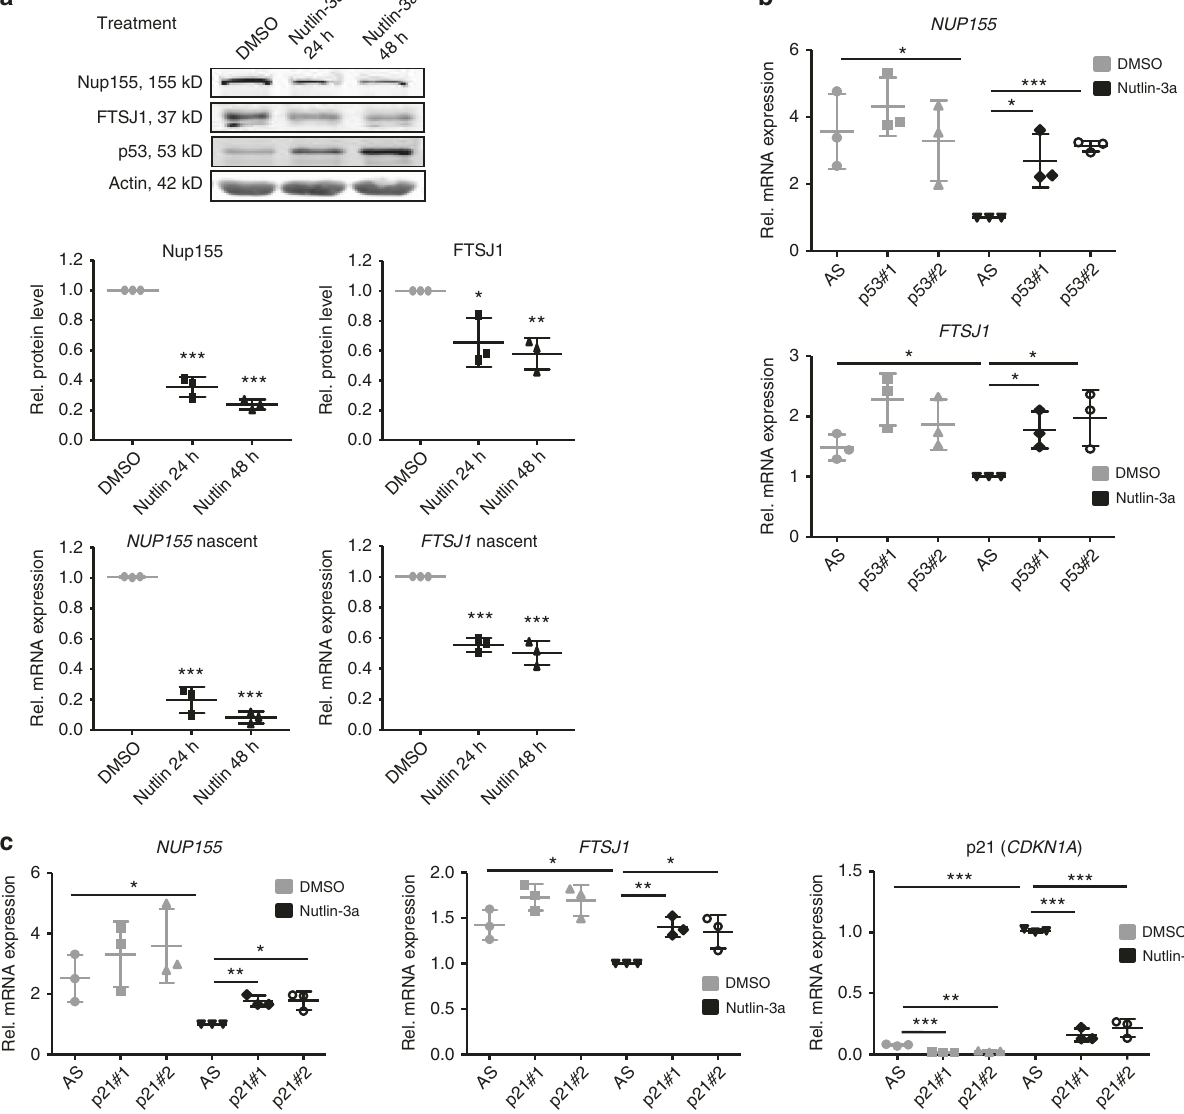
Fig. 6 Nup155 and FTSJ1 are targets of p53-mediated repression. a Sk-Hep1 cells were treated either with DMSO or Nutlin-3a for 24 h and 48 h. Cell extracts were analysed by immunoblotting with indicated antibodies (upper panel). Nup155 and FTSJ1 densitometric analyses of immunoblots derived from three independent experiments (middle panels) normalised to the DMSO condition. Relative nascent mRNA levels of NUP155 and FTSJ1 as measured by qRT-PCR (lower panels). Data are derived from three independent experiments and normalised to the DMSO condition. b Sk-Hep1 cells were treated either with control siRNA (AS) or two different p53 siRNAs (p53#1 and p53#2) for 72 h. Cells were harvested upon 48 h of Nutlin-3a treatment and extracts were analysed by qRT-PCR ( NUP155 upper panel; FTSJ1 lower panel). Data are derived from three independent experiments and normalised to the Nutlin-3a control siRNA condition. c Sk-Hep1 cells were treated either with control siRNA (AS) or two different p21 siRNAs (p21#1 and p21#2) for 72 h. Cells were harvested upon 24 h of Nutlin-3a treatment and extracts were analysed by qRT-PCR ( NUP155 left panel; FTSJ1 middle panel; p21 ( CDKN1A ) lower panel). Data are derived from three independent experiments and normalised to the Nutlin-3a control siRNA condition. * p < 0.05, ** p < 0.01, *** p < 0.001 (Student ′ s t -test); Data are presented as mean ± stdv. Source data are provided as a Source Data fi